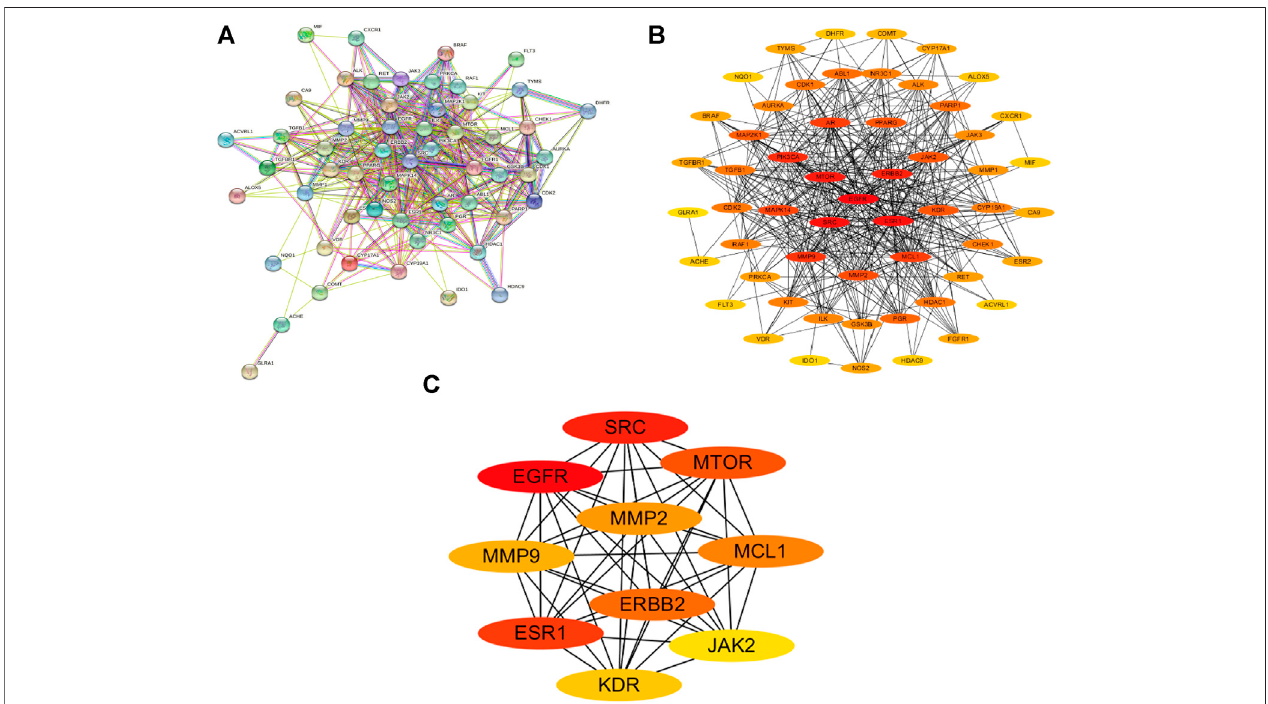
FIGURE 3 | Protein-protein interaction (PPI) analysis. (A) The PPI network was constructed using the plug-in targets from the Search Tool for the Retrieval of Interacting Genes/Proteins database, which were imported into Cytoscape, and the targets were the candidates used for non-small cell lung cancer treatment. (B) Proteins are represented by nodes (colors from red to yellow illustrate the extent to which the medical targets have combined with each other). Edges indicate protein- protein associations. (C) The top 10 targets (hub targets) in the PPI network ranked by maximal clique centrality using the cytoHubba